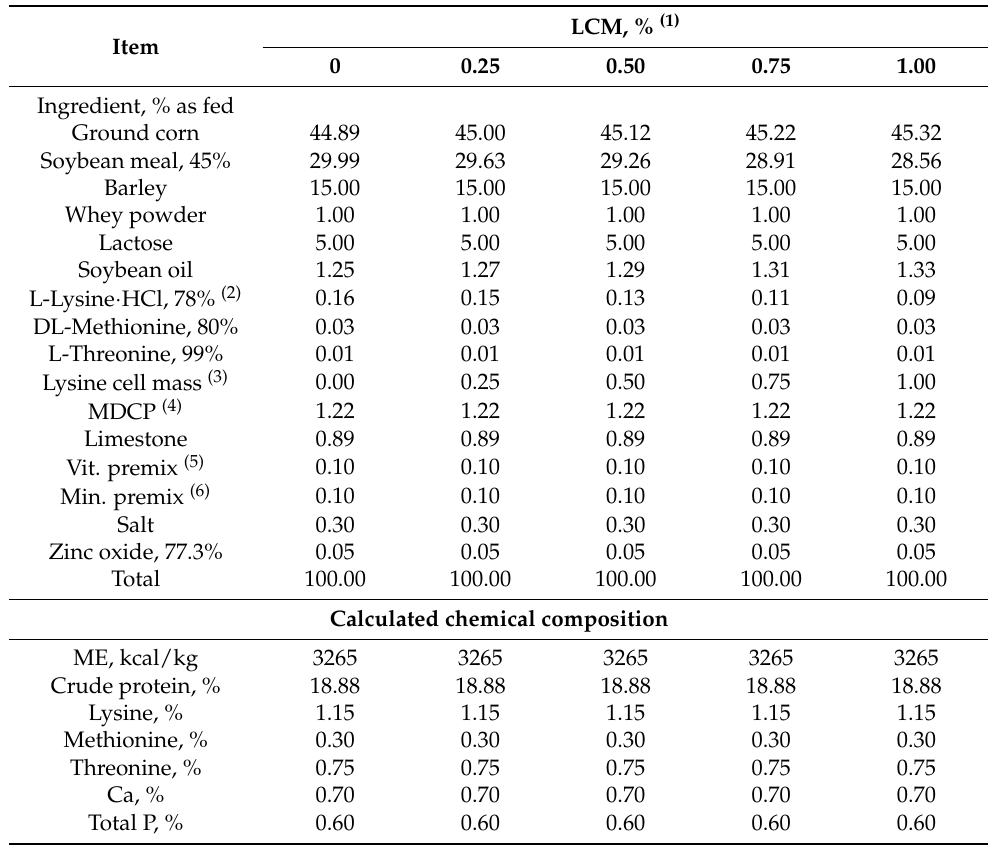
Table 3. The diet formulation and chemical composition of experimental diets for experiment 1 (phase 2).